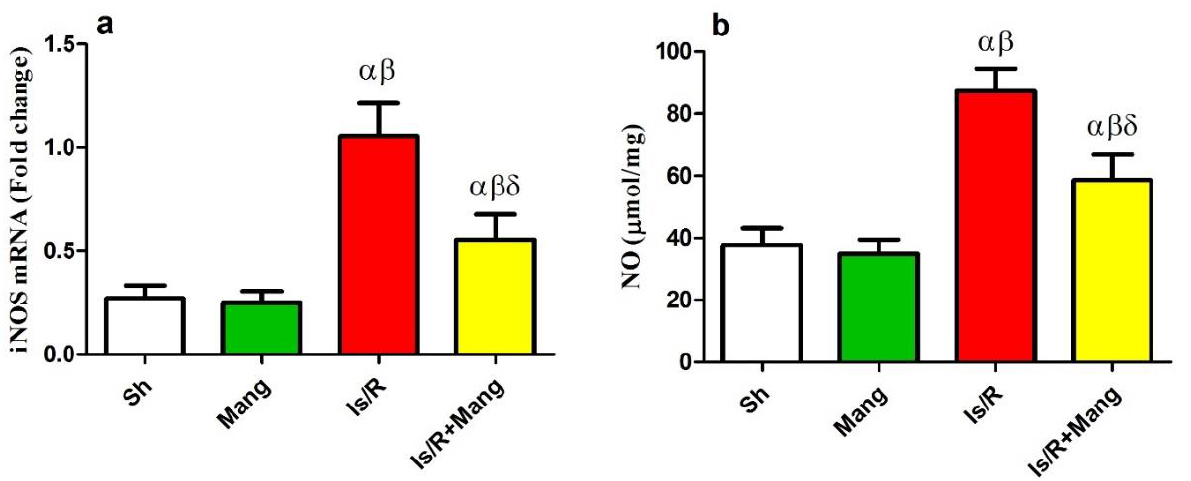
Figure 3. Mang’s (20 mg/kg, i.p) impact on renal ( a ) iNOS mRNA protein expression and ( b ) NO content as nitrosative stress markers. Data were articulated as the mean ( n = 7) ± SD, p value < 0.05 is significant. As compared with sham ( α ), Mang ( β ), and Is/R ( δ ) treated groups.